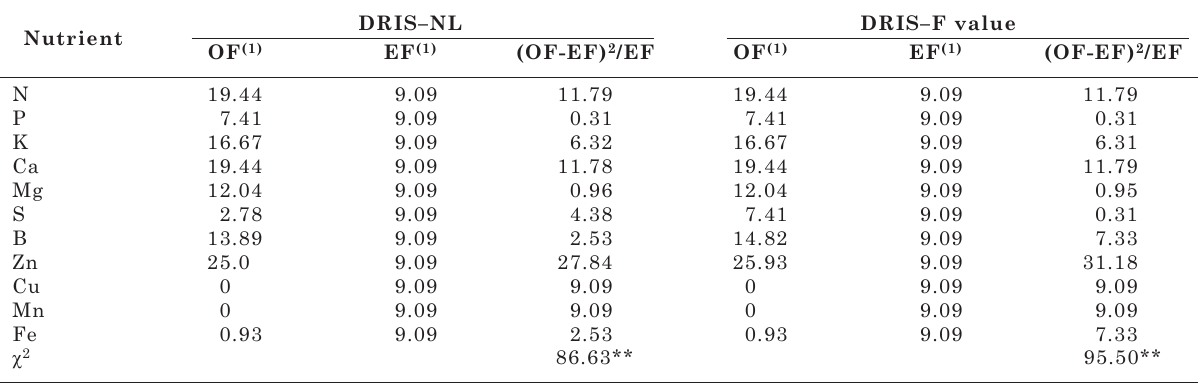
table 4. Chi-square test and values of observed and expected frequencies (%) for n, P, K, Ca, Mg, s, B, Zn, Cu, Mn, and fe as deficient nutrients by the DRis method; norms transformed by natural log (nl) and f